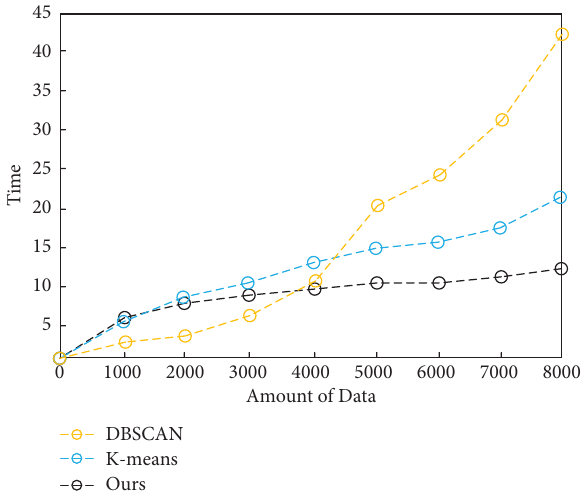
Figure 5: Experimental results of running time of various clus- tering